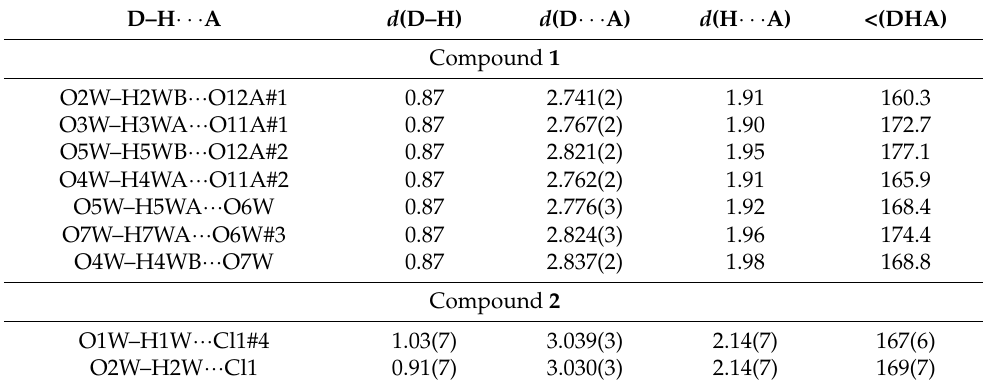
Table 3. Selected hydrogen bond distances (Å) and angles (deg.) for compounds 1 and 2 .